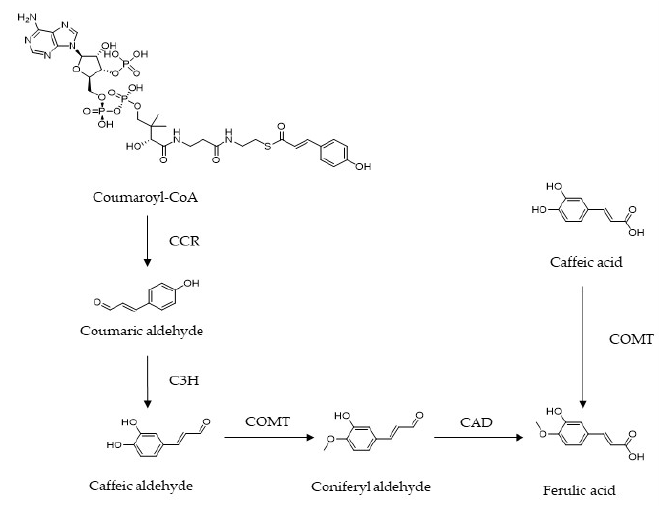
Figure 1. Biosynthesis pathway of ferulic acid. CCR, cinnamoyl-CoA reductase; C3H, p-coumarate 3-hydroxylase; COMT, caffeic acid O-methyltransferase; CAD, coniferyl-aldehyde dehydrogenase.